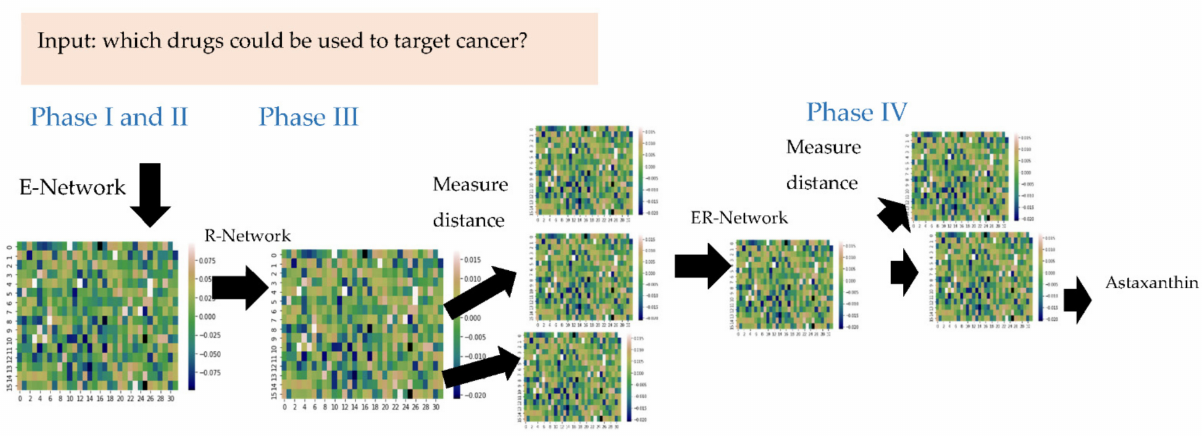
Figure 2. Workflow description. Phase (I&II); After parsing PDFs into single sentences, each sentence is embedded into A 512 × 1 vector (here reshaped into 32 × 16) using the embedding (E) network. Phase (III); the relevance (R) network predicts the answer to the embedded question. The form of the predicted answer is a 512 vector. The distance tween the predicted answer and the embedding of each sentence is calculated. The most relevant sentences are estimated to possess the shortest distance from the embedded question matrix. After that, in phase (IV), the extraction (ER) network predicts the compound embedding for each relevant sentence. The distance between each word embedding and the predicted answer embedding is calculated. The word with the shortest distance between its matrix embedding and the predicted compound embedding is estimated to represent the compound